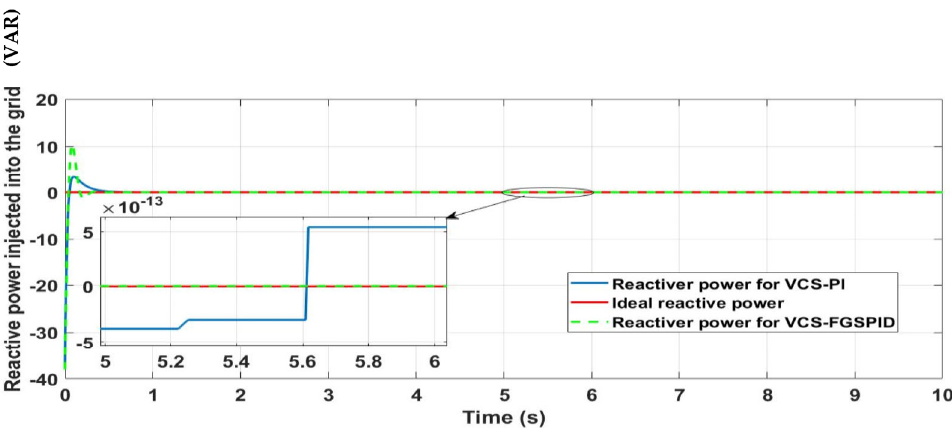
Figure 42. Hardware co-simulation for reactive grid-injected power.